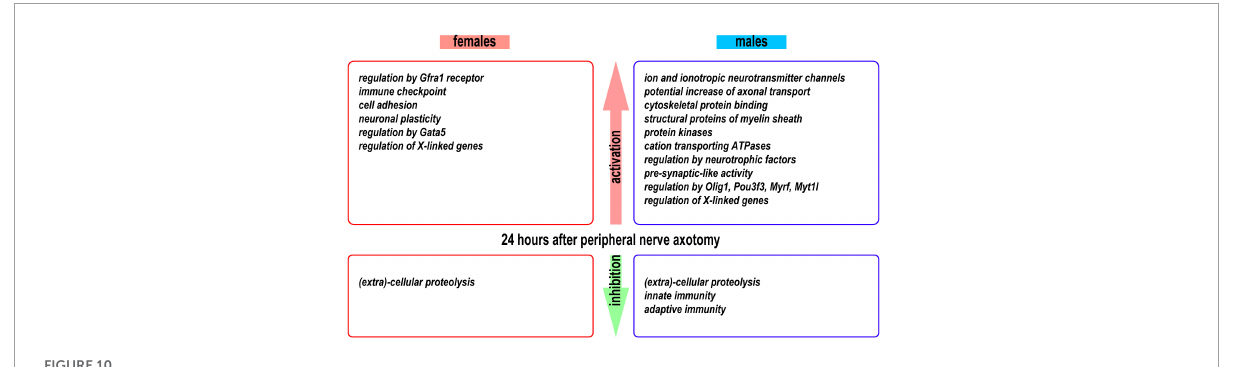
FIGURE10 A summary of activated and inhibited transcriptional programs detected in the proximal nerve stumps 24 h post-axotomy in female and male mice.